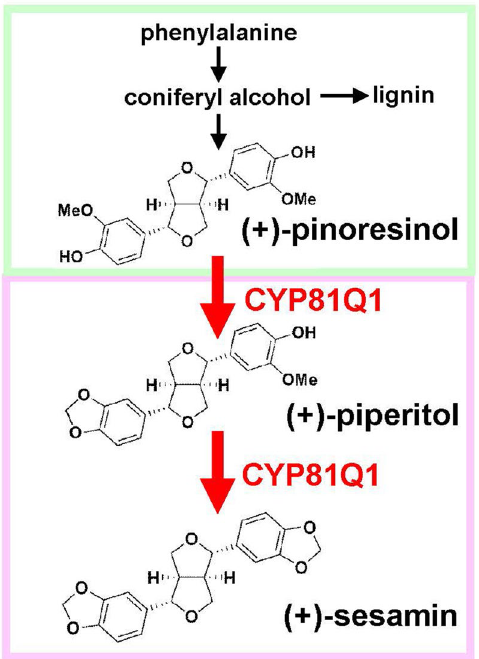
Figure 1. Biosynthesis of (+)-piperitol and (+)-sesamin in Forsythia plants by heterologous expression of the sesame CYP81Q1 gene. Lignan biosynthesis is initiated from phenylalanine. Two coniferyl alcohols are coupled to the precursor lignan (+)-pinoresinol in land plants (green). In sesame plants, CYP81Q1 sequentially synthesizes (+)-piperitol and (+)-sesamin